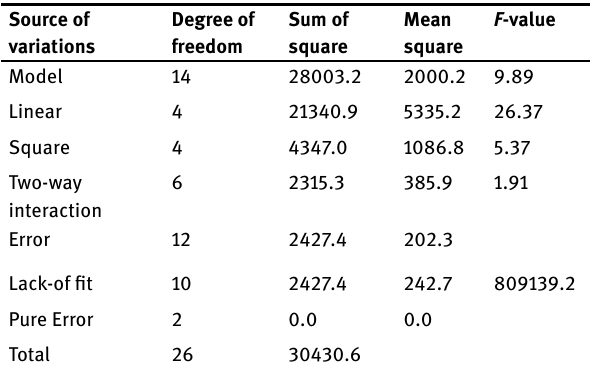
Table 3: ANOVA results for optimization of heavy metal adsorption capacity of micronized calcite.